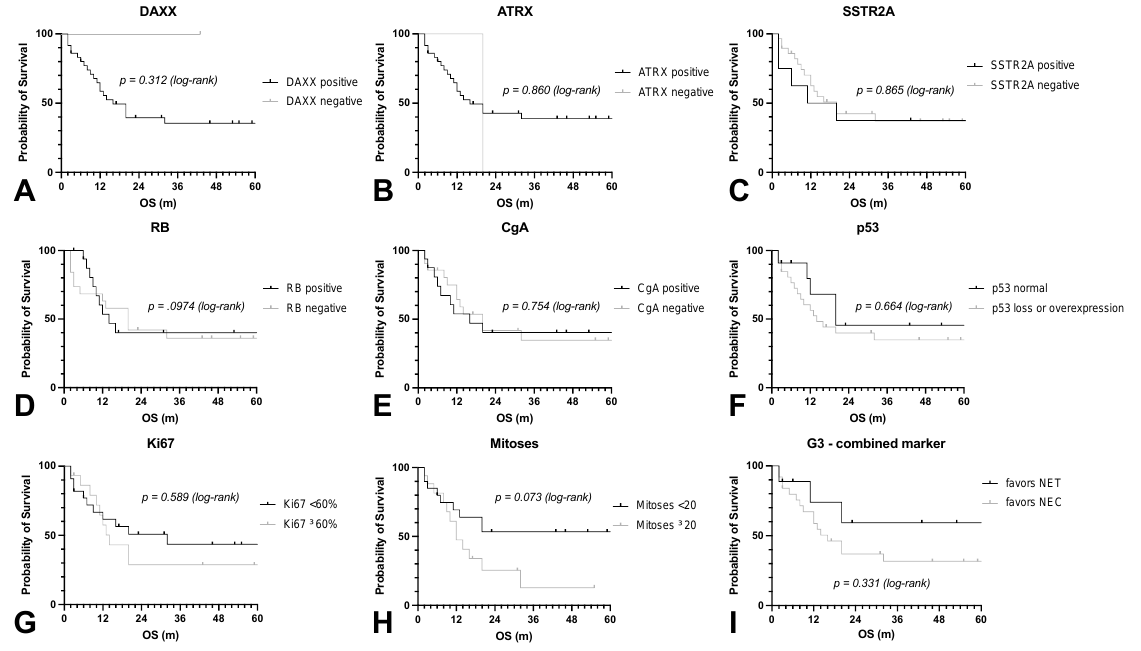
Figure 2. Overall survival in relation to histological markers. The overall survival (OS) of all enrolled patients with NEN G3 was calculated with respect to the expression or intensity of DAXX ( A ), ATRX ( B ), SSTR2A ( C ), RB ( D ), Chromogranin A (CgA, ( E )), p53 ( F ), Ki67 ( G ) and mitoses ( H ). Two groups were distinguished by taking all markers together: favors NET G3 and favors NEC ( I ). GEP: gastroenteropancreatic, NEC: neuroendocrine carcinoma, NEN: neuroendocrine neoplasia, NET: neuroendocrine tumor, OS: overall survival, P: pulmonary.